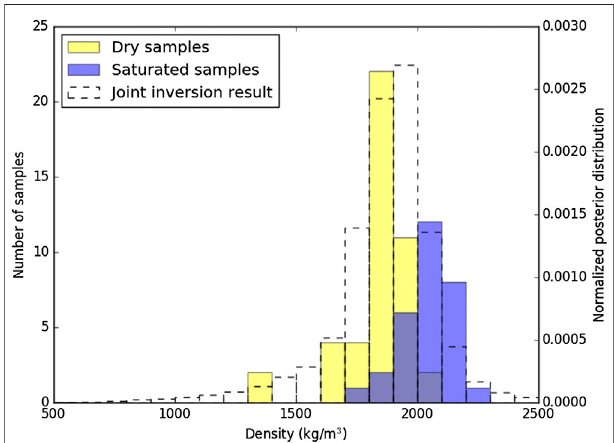
FIGURE 4 | Densities measured on dry and water-saturated samples of trachyte from the Puy de D ˆ ome volcano. The dashed histogram corresponds to the normalized distribution of the 3D density model resulting from the joint inversion ( Figure 7